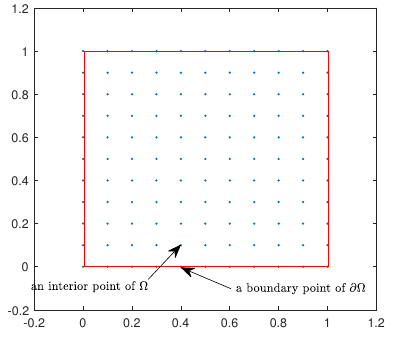
Figure 1. The domain Ω and distribution of points.